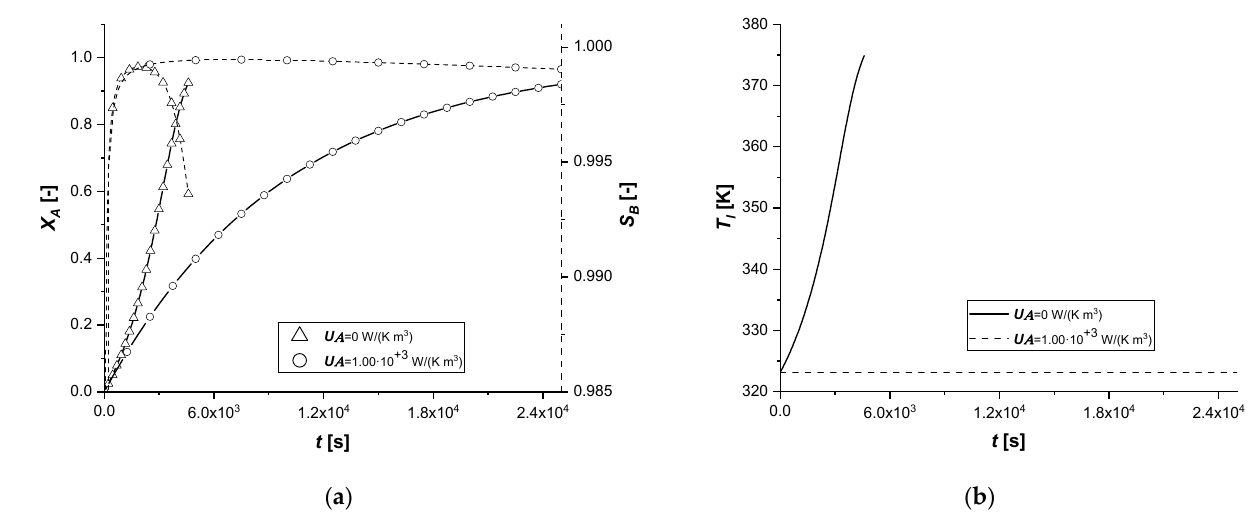
Figure 32. ES UA investigation. ( a ) Bulk profiles over time of X A and S B . ( b ) Bulk profile of T l over time.